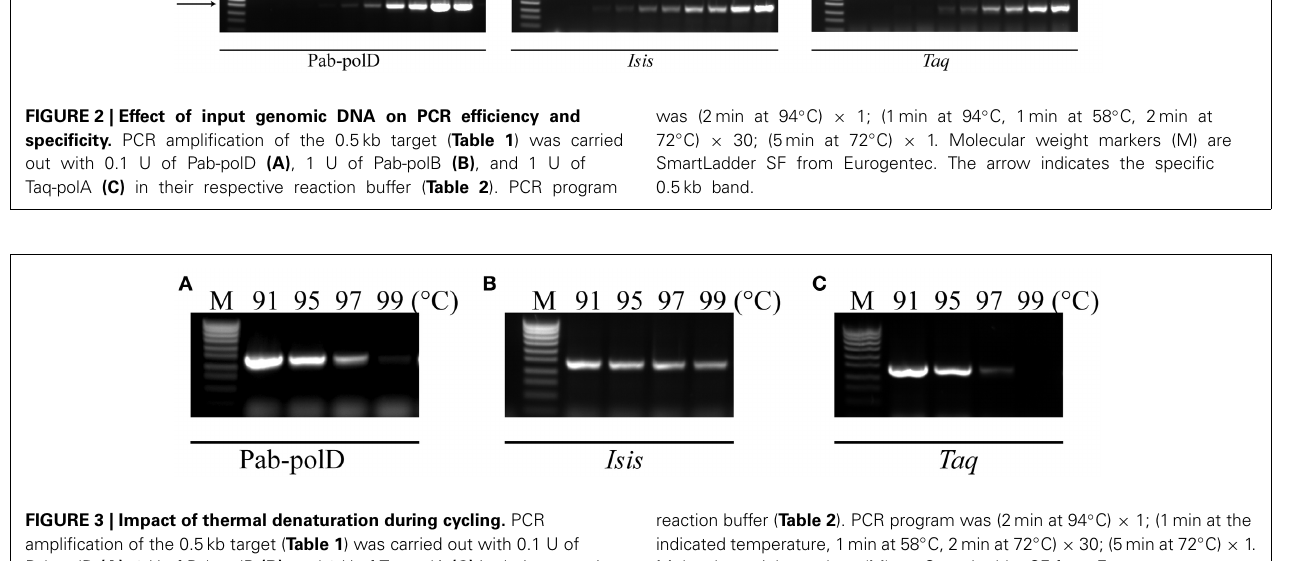
reaction buffer ( Table 2 ). PCR program was (2min at 94 ◦ C) × 1; (1min at the indicated temperature, 1min at 58 ◦ C, 2min at 72 ◦ C) × 30; (5min at 72 ◦ C) × 1. Molecular weight markers (M) are SmartLadder SF from